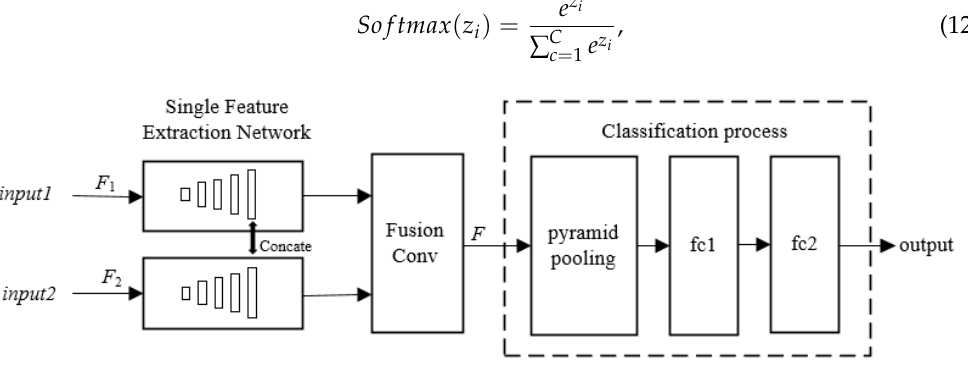
Figure 5. Structure of classification network.